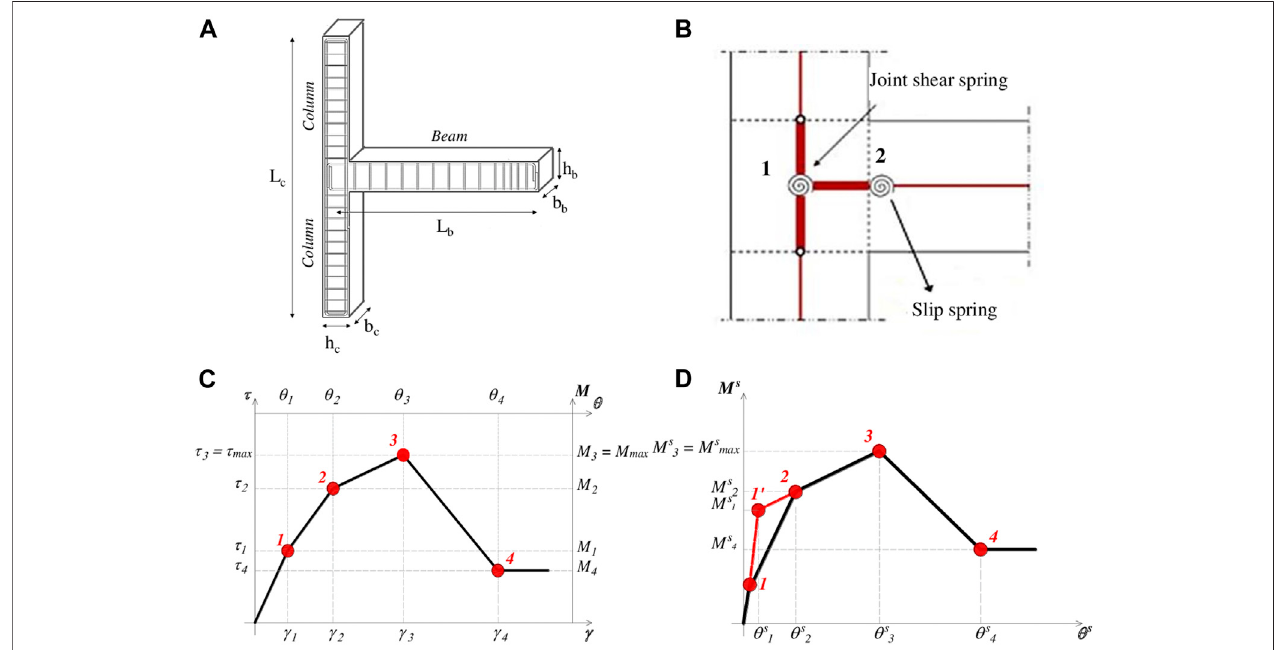
FIGURE 1 | Scheme of the 2D joint under consideration (A) ; sketch of the used “ scissors model ” (B) ; multilinear shear stress-strain (or moment-rotation) law assigned to spring 1 (C) ; multilinear moment-rotation law assigned to spring 2 (D) .